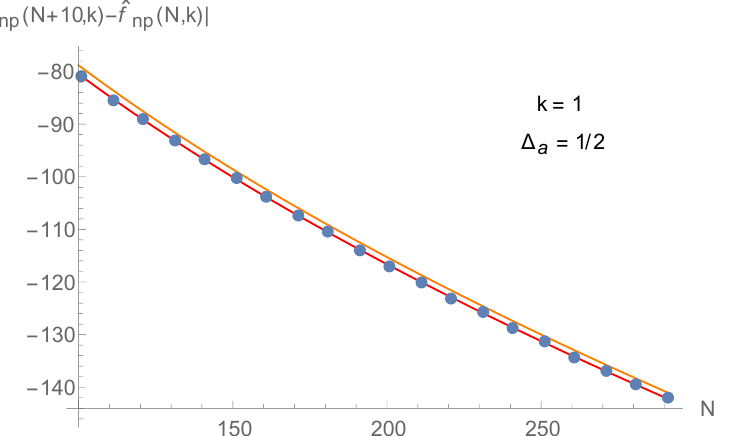
Figure 4 . Numerical values of non-perturbative corrections (4.62) (blue dots) versus fitting curves (orange/red lines include the first three/five terms in the r.h.s. of (4.63),